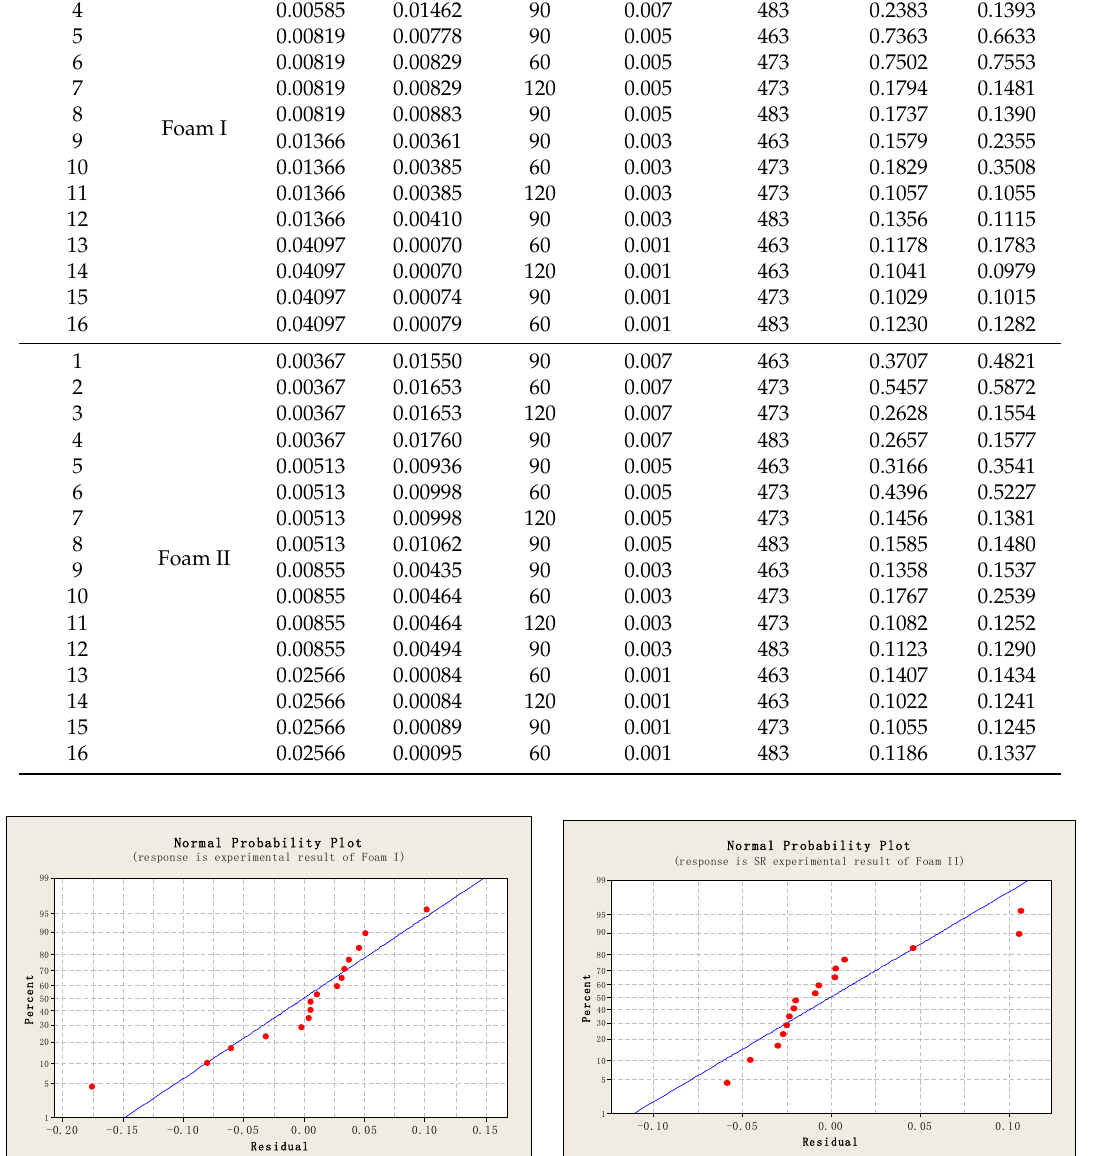
Figure 4. Residual analysis of normal probability plots for shrinkage ratio of Foams I and II.